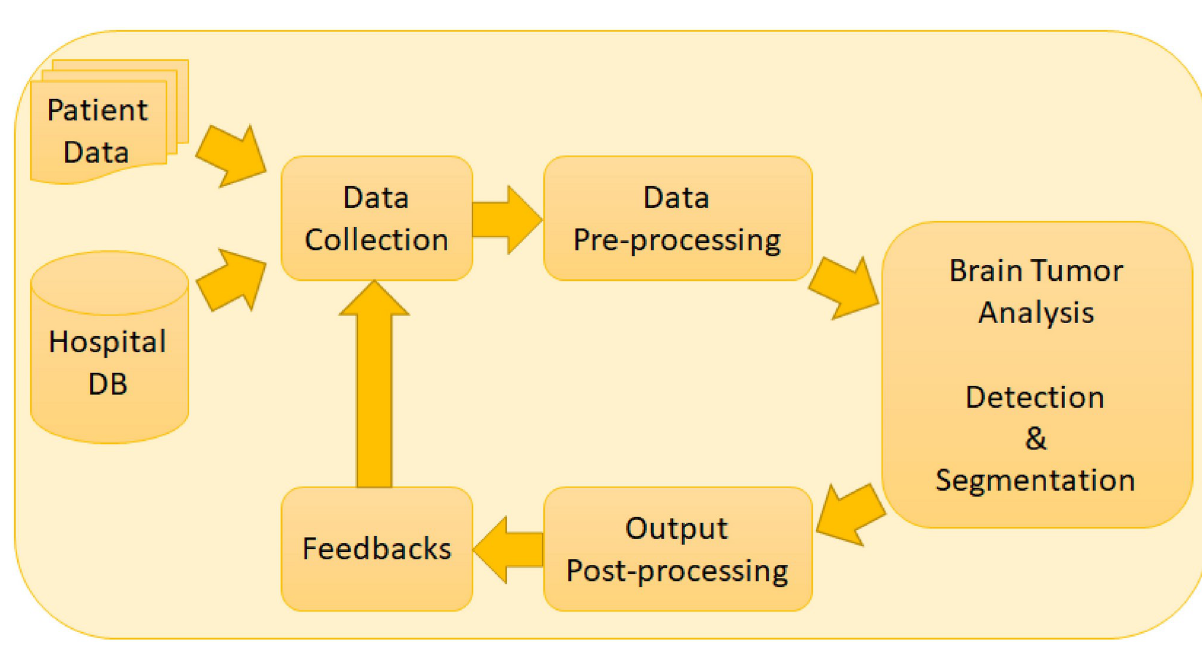
Fig 2. Proposed automated system for brain tumor